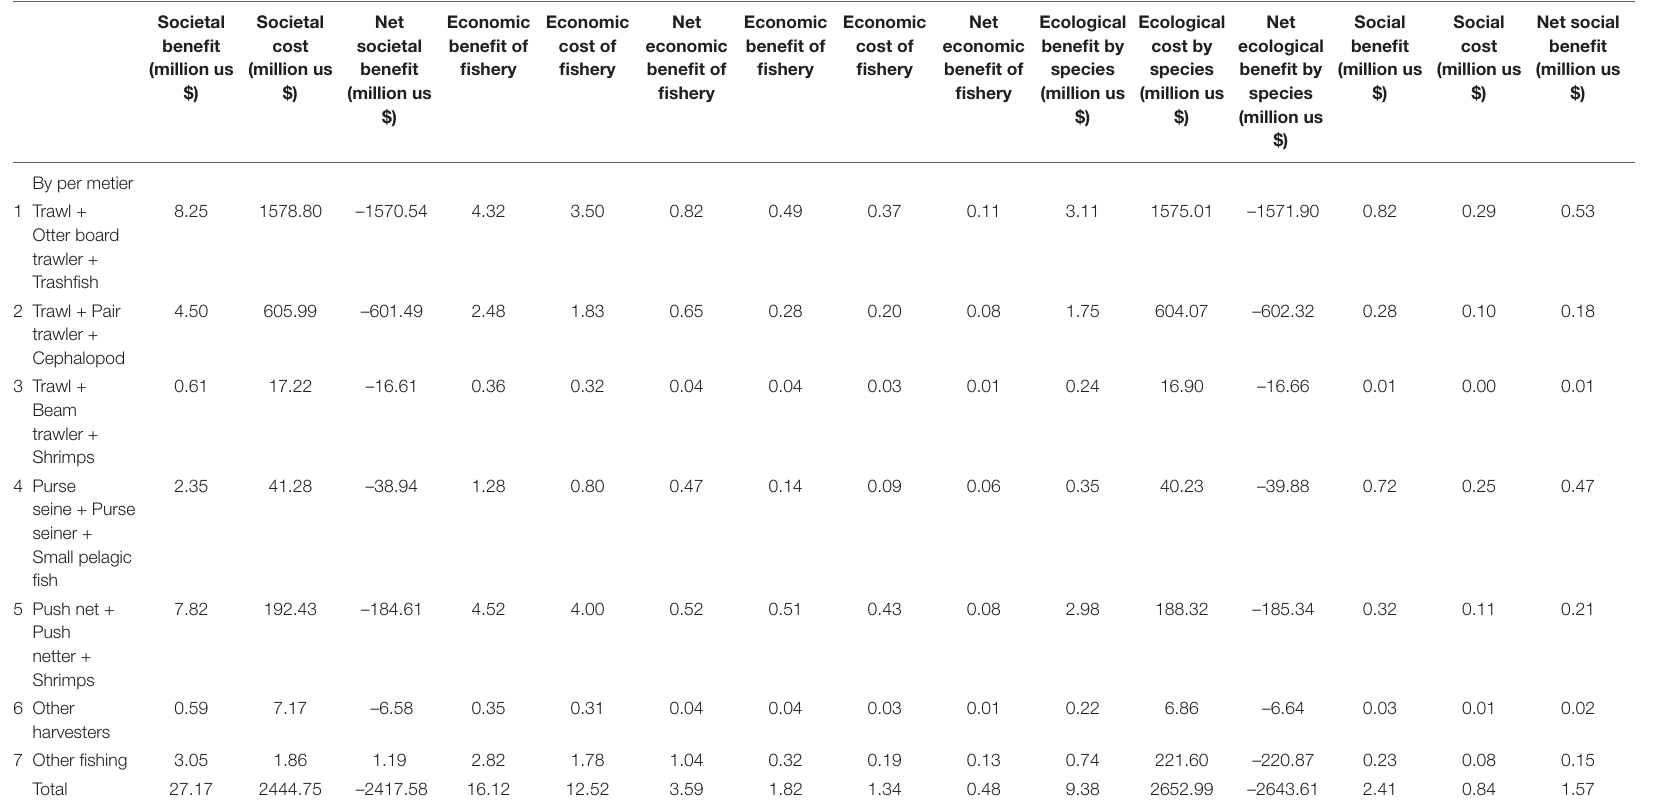
TABLE 6 | Results on society-wide performance in 2015 (in million us